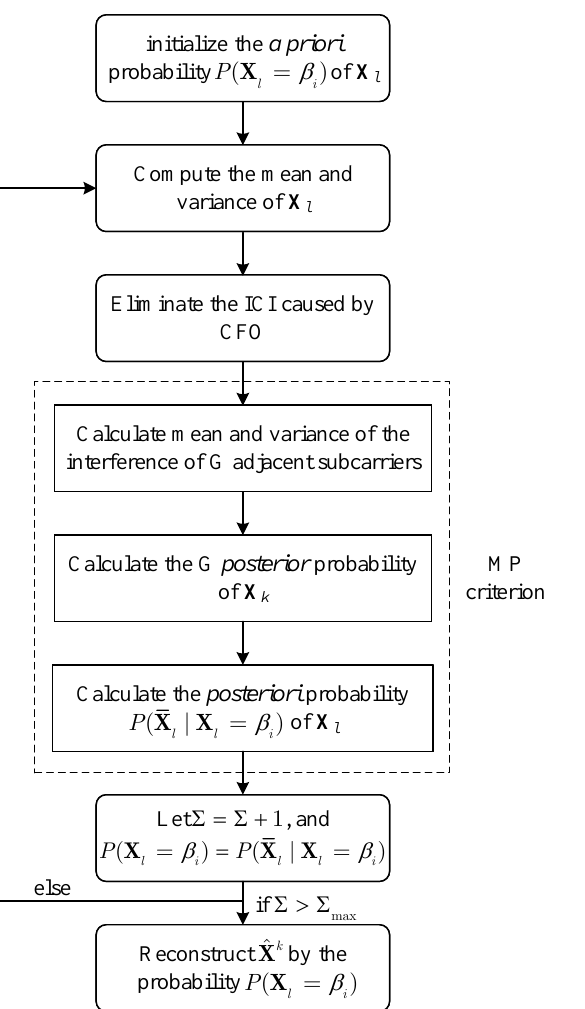
Figure 2. Block diagram of the MP-criterion-based